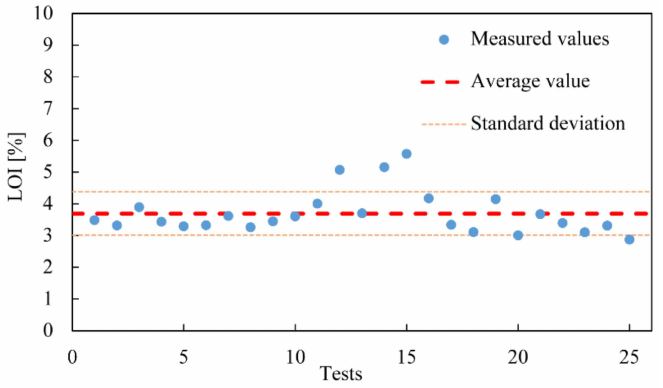
Figure 4. Results of the target waste material in terms of fixed carbon using the LOI technique.